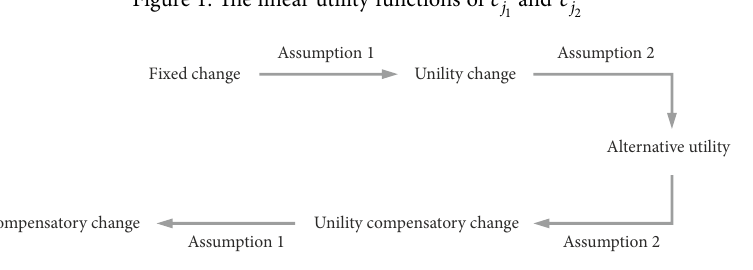
Figure 2. The utility conversion